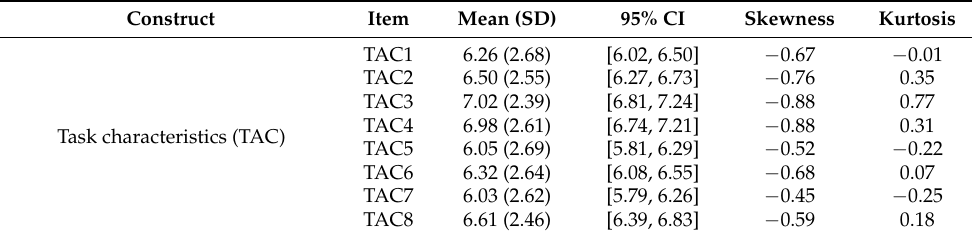
Table 4. Descriptive statistics of the measurement